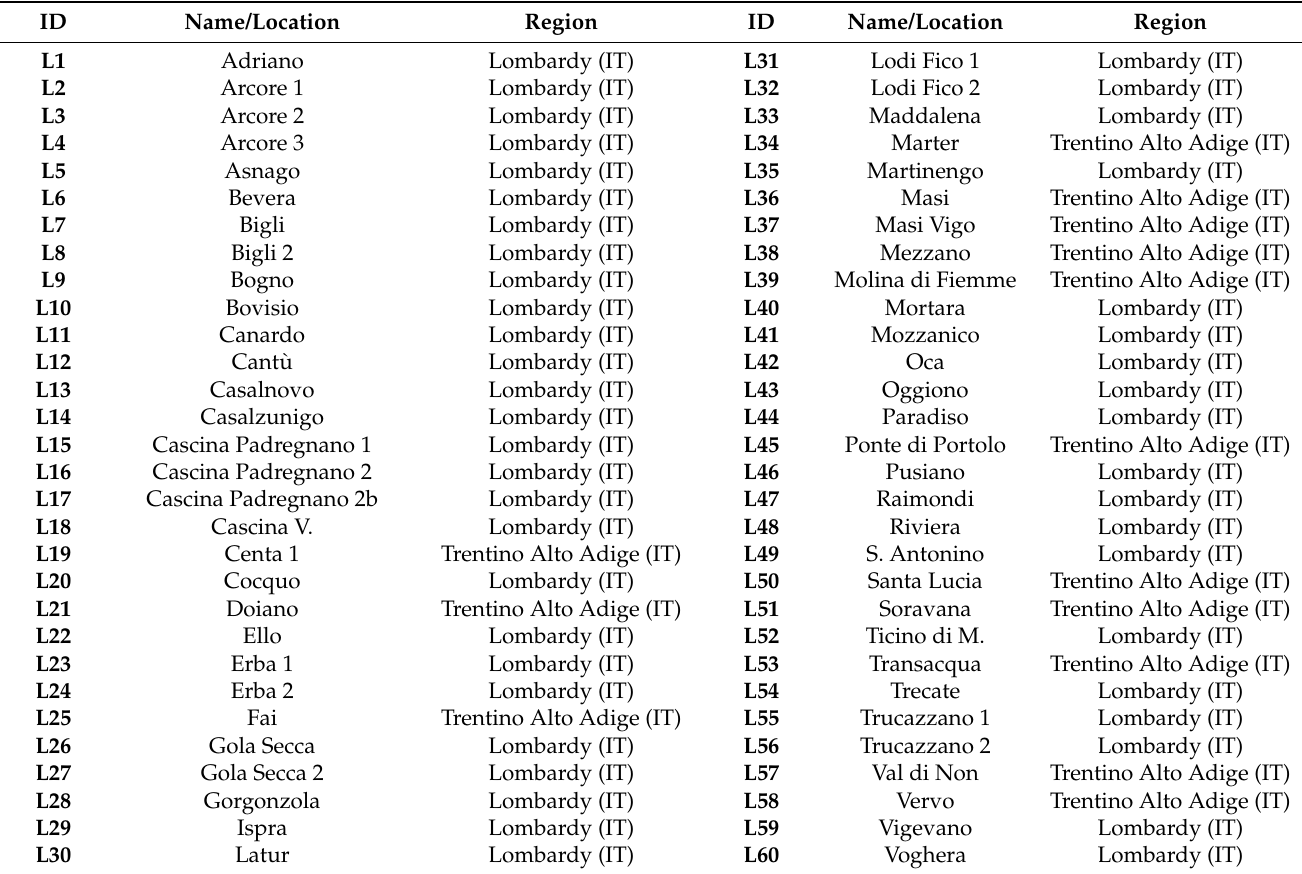
Table 1. List of the studied accessions with ID, name or location and region of